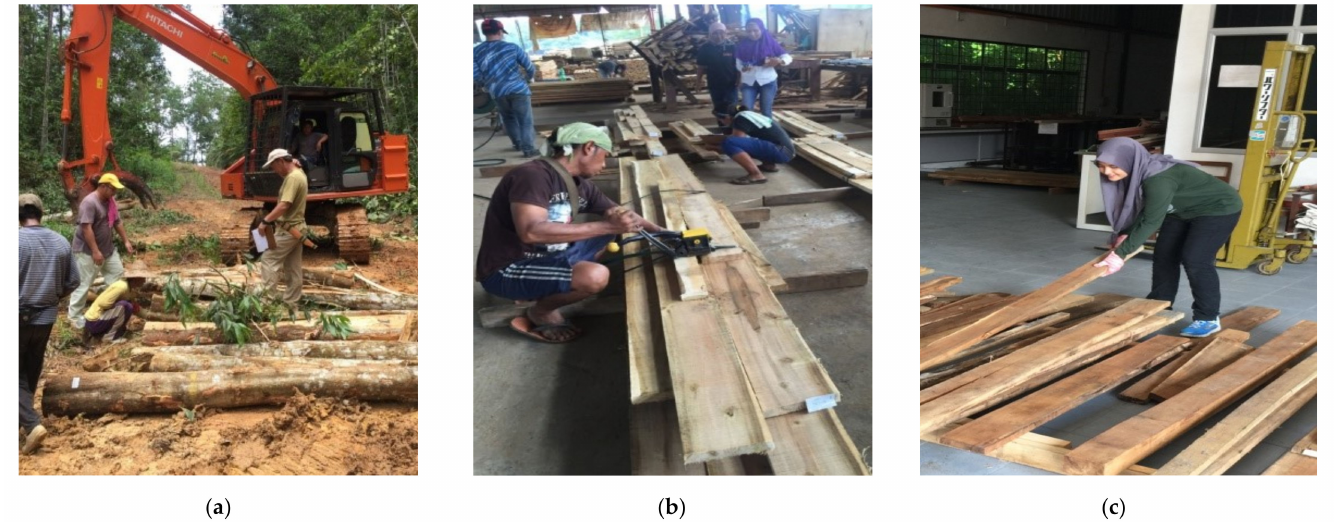
Figure 1. Timber collection process. ( a ) The plot number were marked on Acacia hybrid logs at Daikin Plantation. ( b ) The logs were sawn and trimmed into plank size. ( c ) The timber was stacked according to age groups in airdry